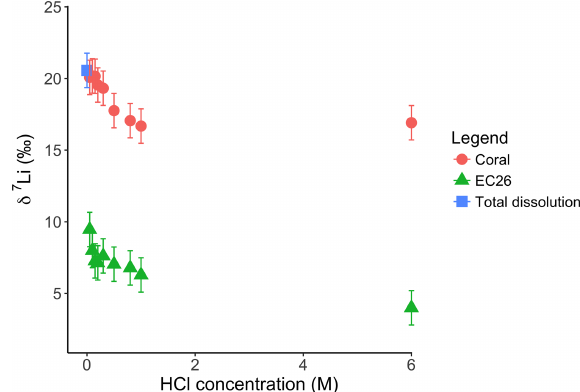
Figure 8. Lithium isotope composition of leaching solutions as a function of their HCl concentrations. Triangles and circles repre- sent the δ 7 Li composition of the solutions used to leach a Neo- proterozoic dolostone and modern coral, respectively. The square shows the composition of the coral total dissolution. Both coral and dolostone solutions show similar trends, suggesting the release of silicate-bound Li at higher HCl concentrations. This is surprising as the coral is almost exclusively aragonite, so the release of iso- topically light Li is not expected. This also implies that total dis- solution in dilute HNO 3 does not release isotopically light Li into solution, although no residue was observed during dissolution in dilute HNO 3